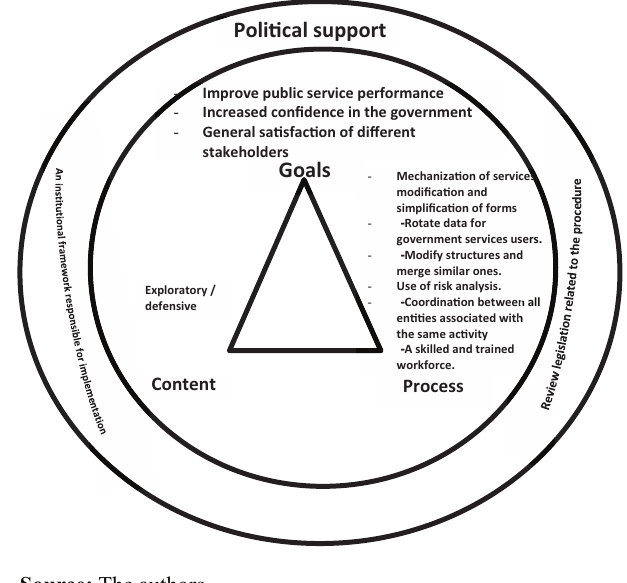
Figure 1 Objectives, operations and content of the